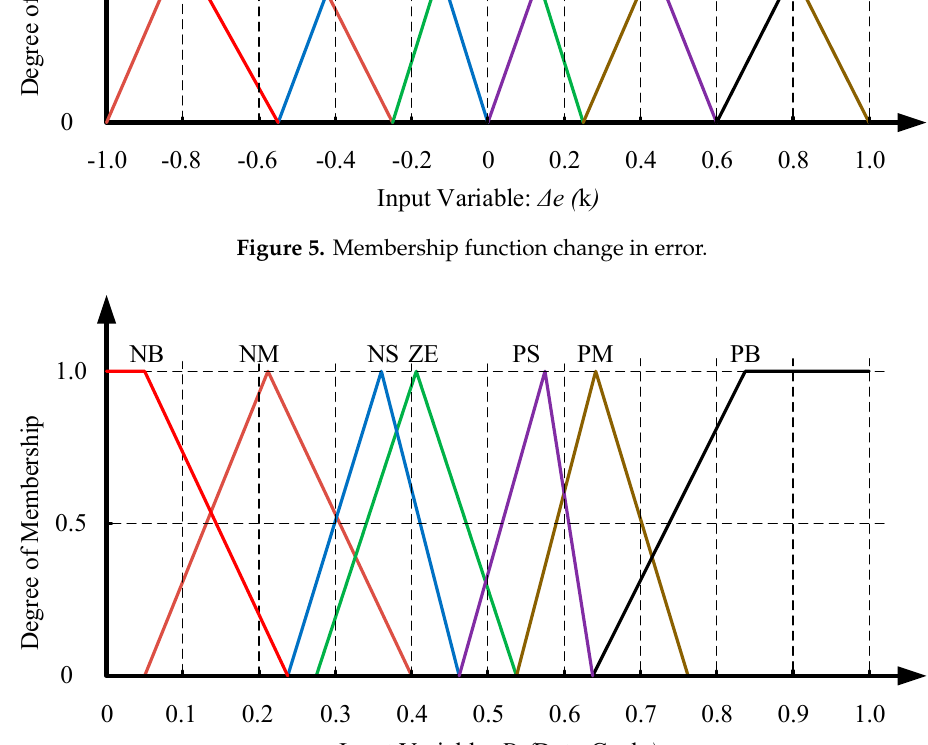
Figure 6. Membership function output.